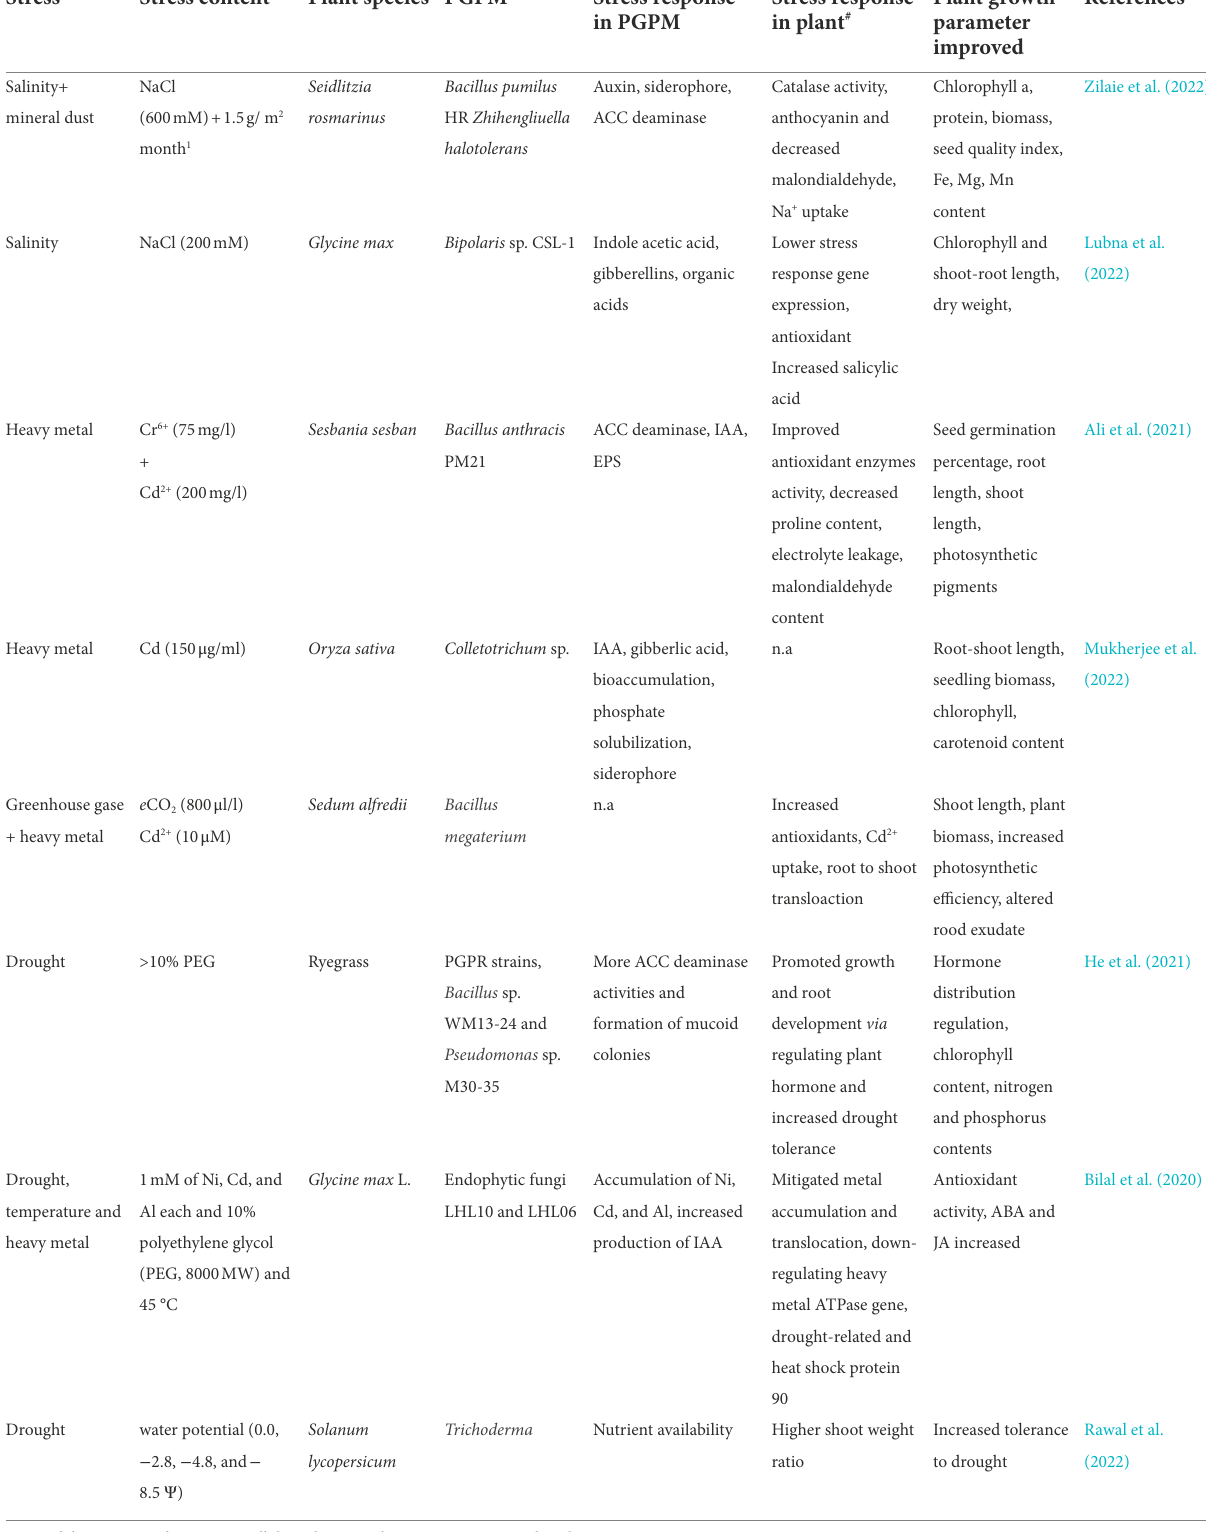
TABLE 1 Impact of climate change induced stress on plant-microbe